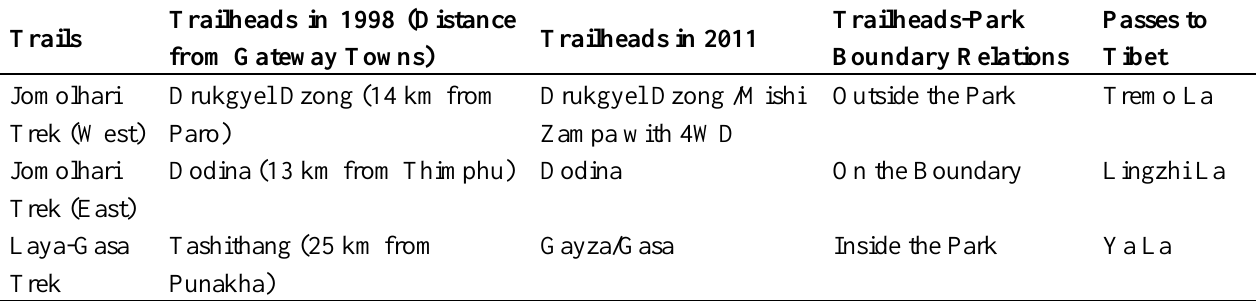
Table 2. Three trails and their trailheads in Jigme Dorji National